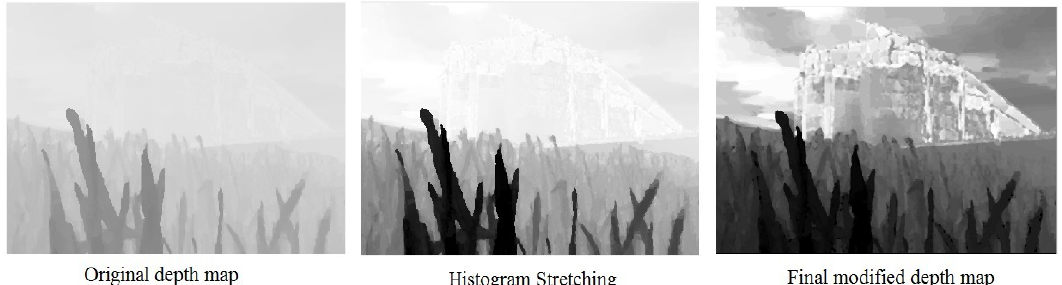
Figure 4. Details of our proposed 3D point cloud estimation method.